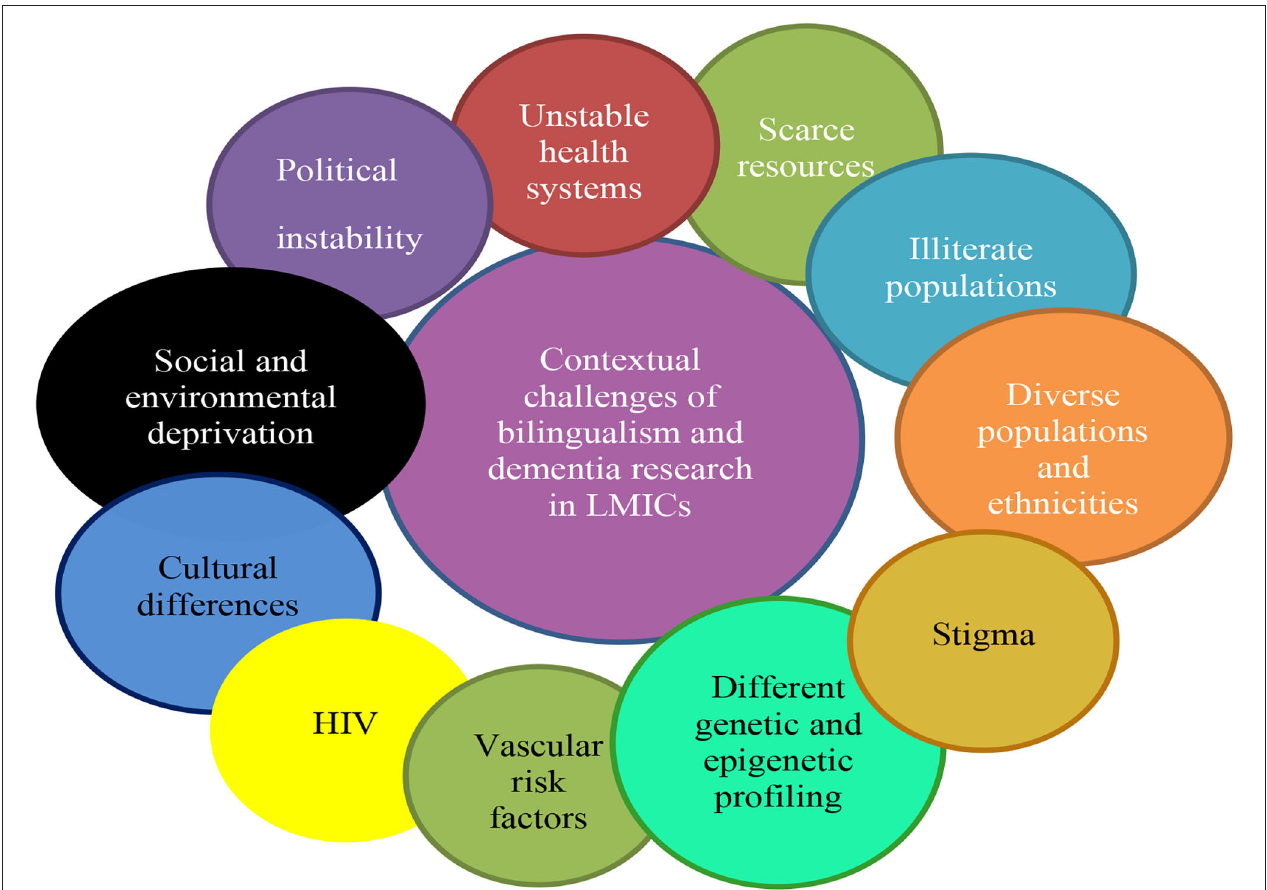
FIGURE 1 | The key contextual challenges of bilingualism and cognitive reserve research in LMICs.